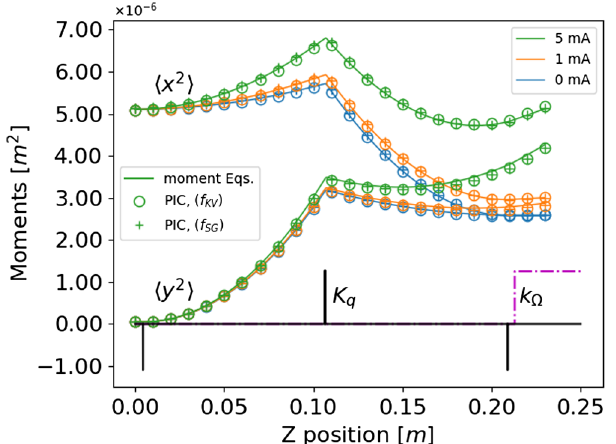
FIG. 2. Comparison of solutions of the moment equations (solid lines) with solutions from the PIC code Warp (circular and cross symbols). PIC simulations were run with an initial Kapchinskij-Vladimirskij (K-V) beam distribution (circles) [27] as well as a semi-Gaussian (crosses) distribution using 40K particles. Comparisons are for beams with 0, 1, and 5 mA